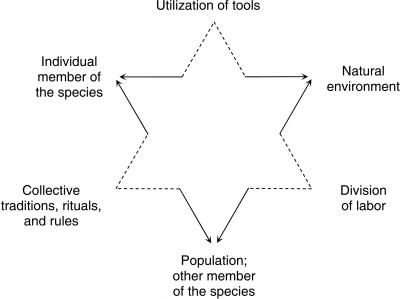
Structure of Activity in Transition from Animal to Human after Engeström [10].